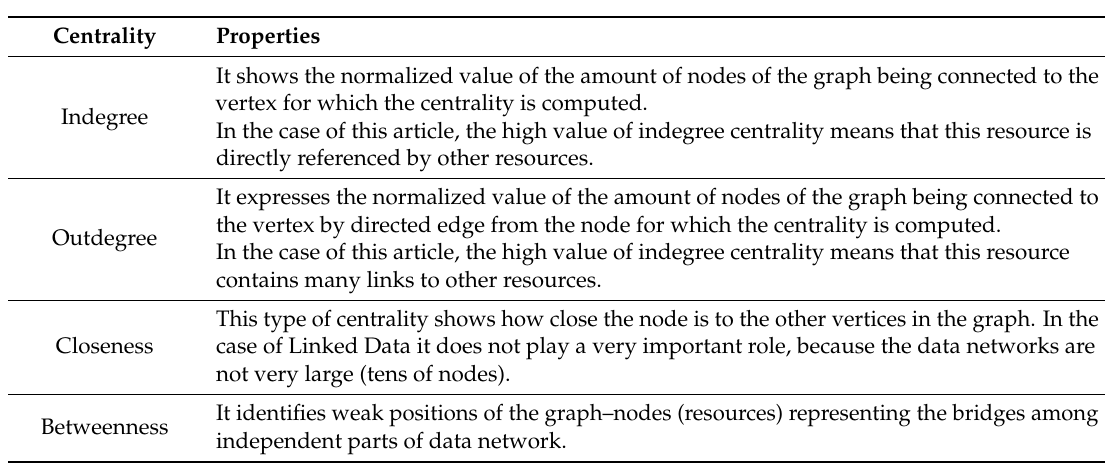
Table 1. Types of